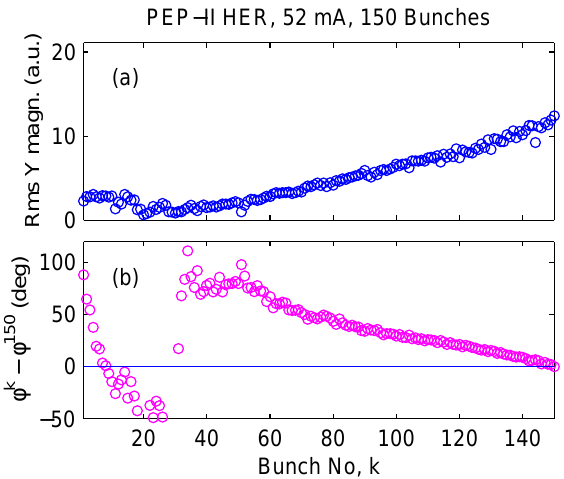
FIG. 5. (Video) A single frame from Video 1 depicts a vertical instability transient in a 150-bunch train in the PEP-II HER (same data as Figs. 1–4). (a) Oscillation magnitudes of the 150 bunches on a single turn and (b) relative phase space angles (cid:2) f k 2 f 150 (cid:3) of the bunches on the same turn. frame shows the oscillation magnitudes a k and relative phase space angles (cid:2) f k 2 f 150 (cid:3) of the 150 bunches on a single turn. Successive frames are separated by 20